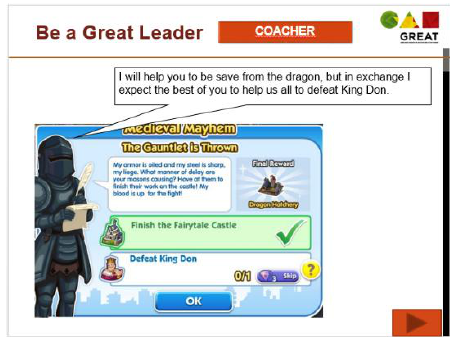
Figure 3. Leader - Coacher